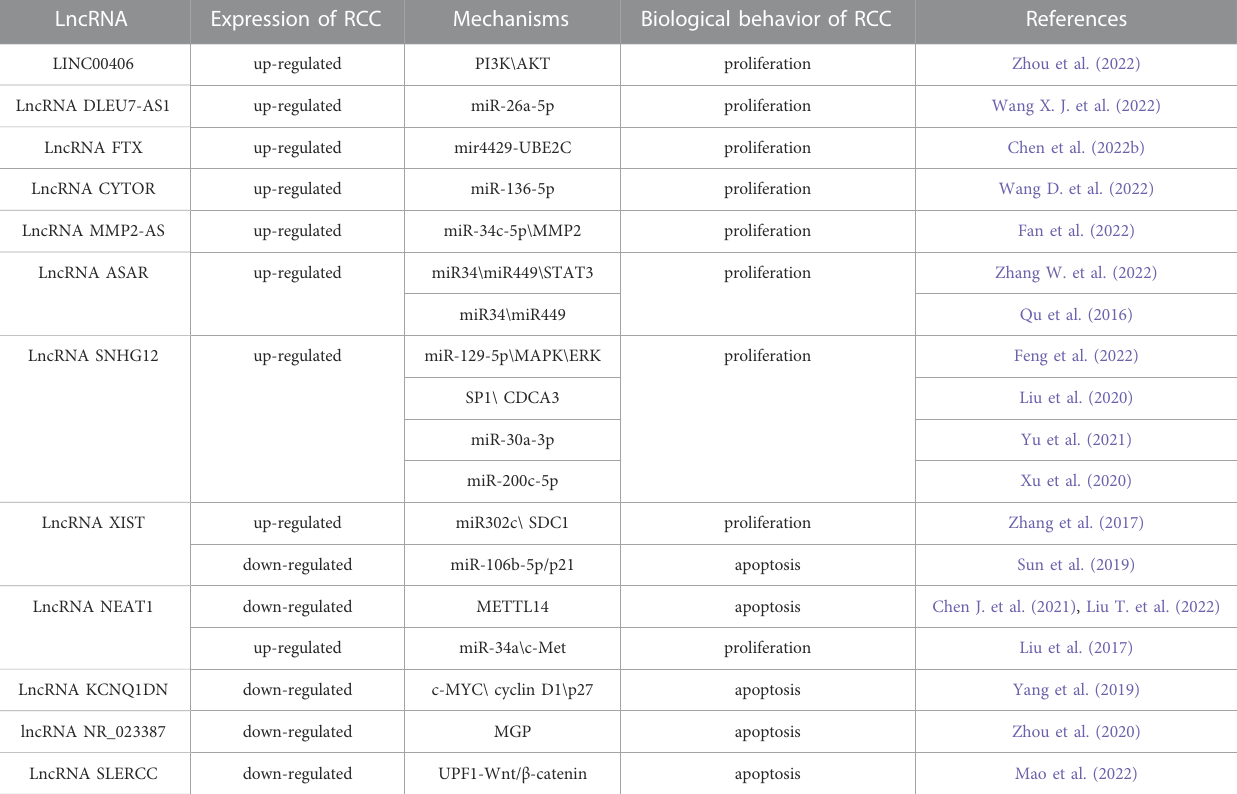
TABLE 1 The expression of lncRNAs and regulatory mechanisms in